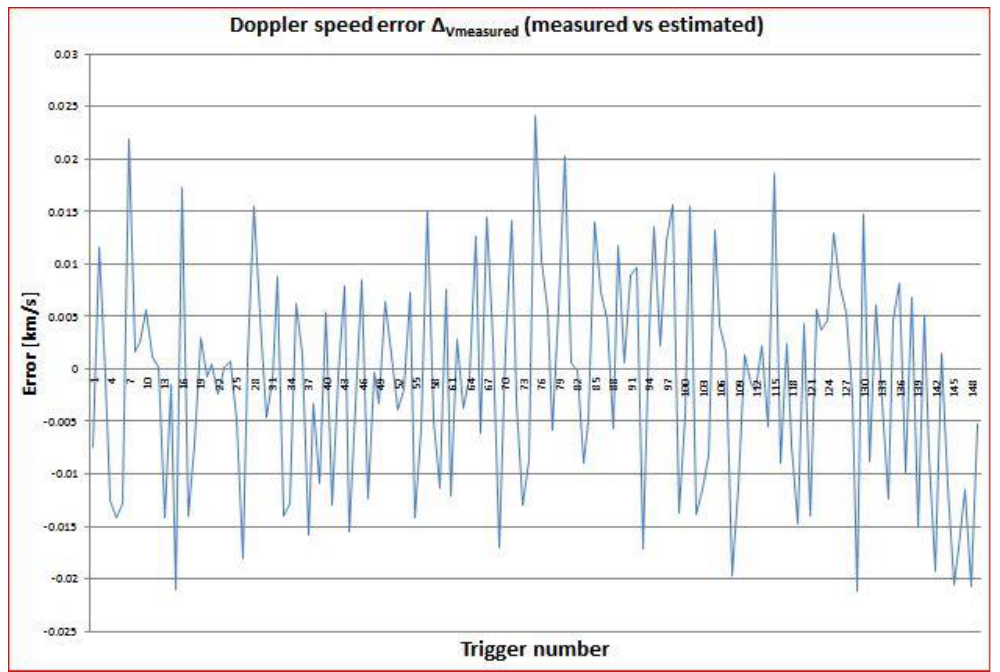
Figure 10. Difference between the measured and the TLE-computed values for Doppler speed as a function of trigger number (time) for COSMOS2932.